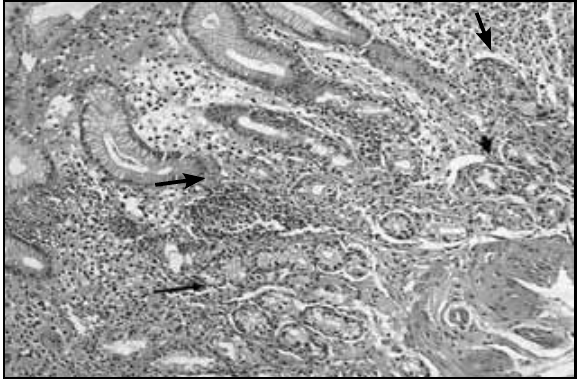
Figure 1 – Oxyntic gastric mucosa of patient with advanced atrophic body showing: diffuse mononuclear cell infiltration of the entire thickness of the lamina propria ; few remained acidopeptic glands (short arrow), and pseudopyloric metaplasia (long arrow) (HE staining, 100×) HE: hematoxylin and eosin.